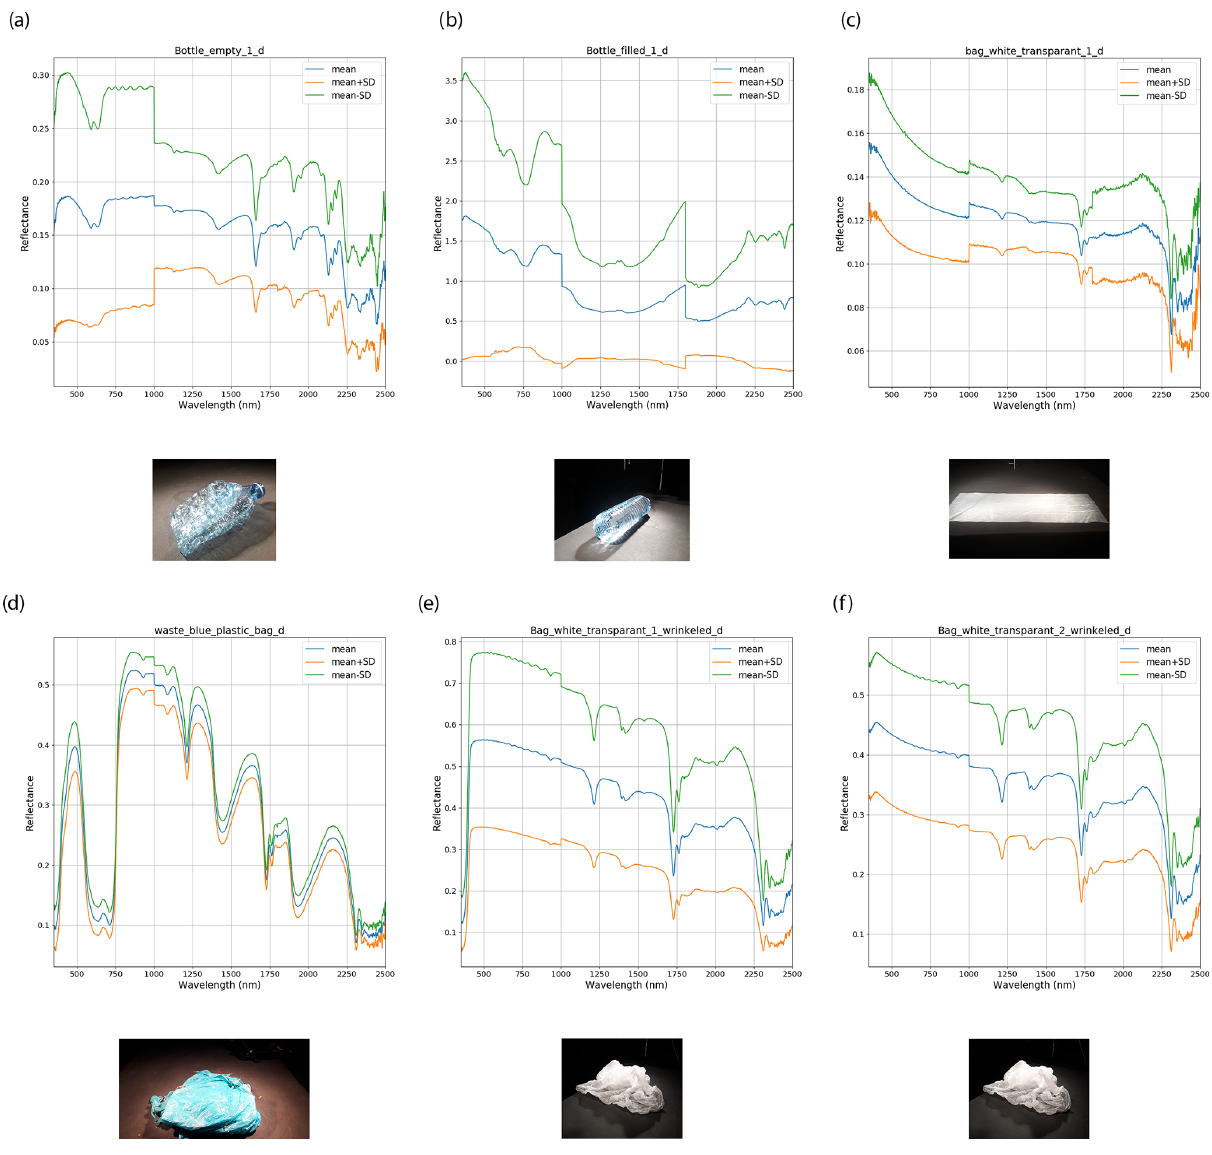
Figure 11. Mean and SD for the bags and